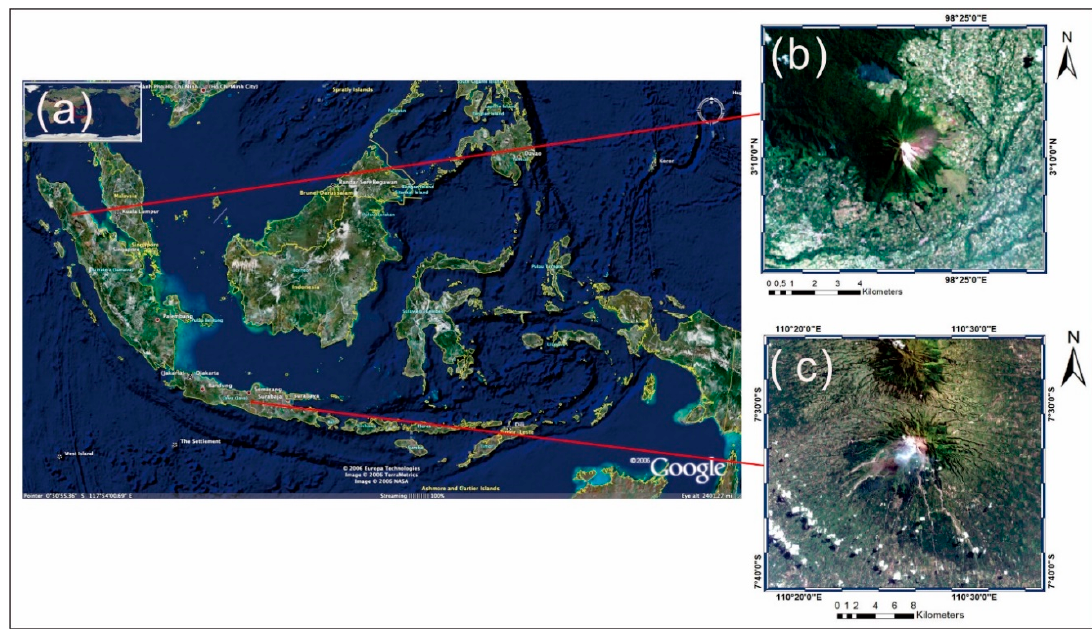
Figure 1. Map of Indonesia using Google Maps ( a ); location of Mt. Sinabung ( b ) and Merapi ( c ) on Sumatra and Java Islands from USGS earth explorer website [20].